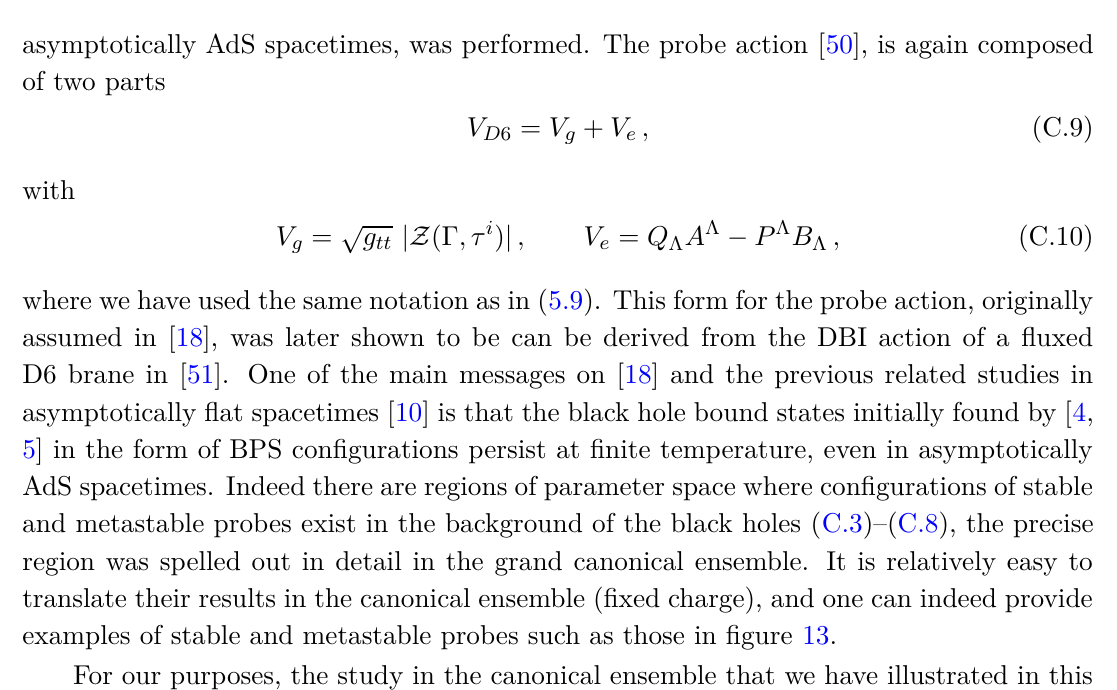
Figure 13 . Example of fluxed D6 brane potential for the spherical AdS 4 solution from the S 7 truncation. The plot is for the parameters l = 1 / 2 , T = 0 . 05( blue ) , 0 . 11( orange ) , 0 . 38( green ) , AdS with probe charge κ = 0 . 44 . For each of the solutions we have shifted the radial coordinate in such a way that the horizon is at r = 0